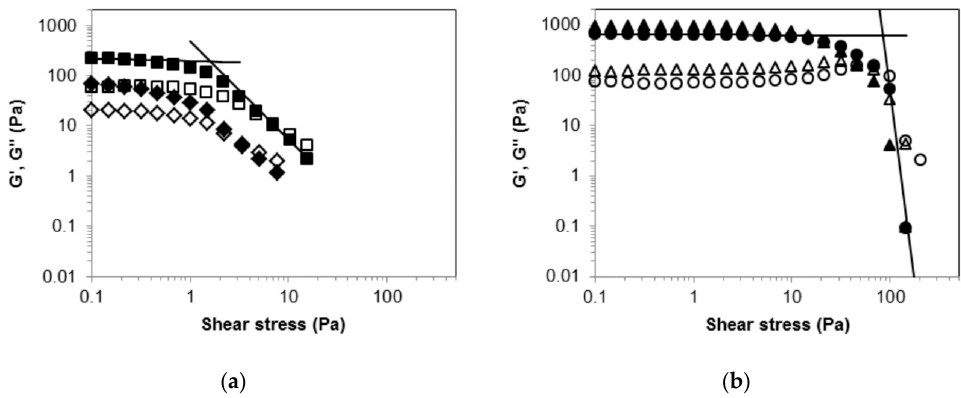
Figure 4. Amplitude sweep tests. Storage modulus, G (cid:48) , (filled symbols) and loss modulus, G”, (empty symbols) as functions of stress amplitude at an oscillation frequency of 1 Hz for 1% w / w gels in para ffi n oil: ( a ) Freshly prepared (R) -9-HSA gel (squares) and the same gel after eight days of aging at 25 ◦ C (diamonds); ( b ) freshly prepared (R) -12-HSA gel (circles) and the same gel after eight days of aging at 25 ◦ C